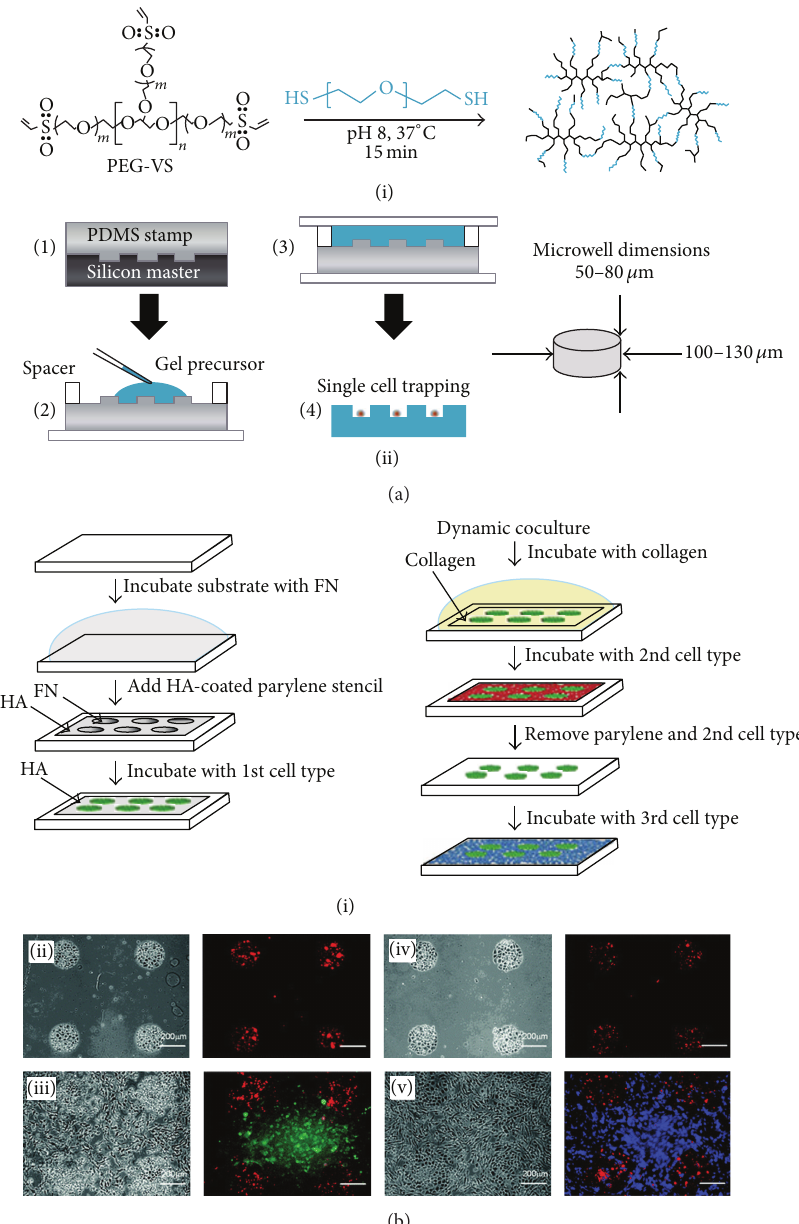
Figure 1: (a) Fabrication of single HSCs microwell array. (i) Reactive thiol and vinyl sulfone end-groups on poly(ethylene glycol) (PEG) precursors. (ii) Overview of hydrogel microwell array fabrication. A PDMS stamp is cast on a silicon master (step 1). This stamp is used as a template to crosslink a PEG gel containing the complementary microwell array topography (steps 2 and 3). Upon swelling and washing, the hydrogel surface is used to trap individual HSCs (step 4). Typical dimensions of microwells are indicated. (b) (i) Coculture